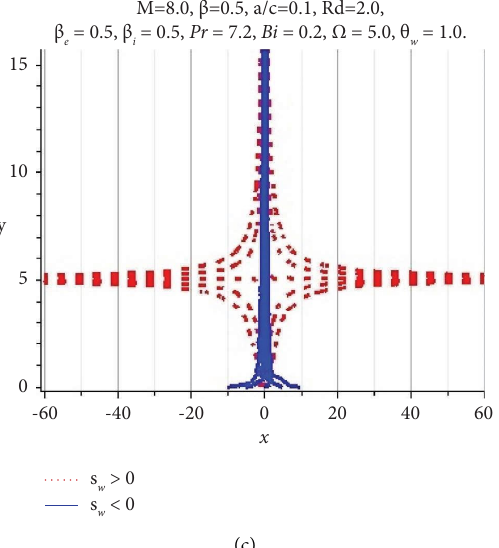
Figure 10: Stream lines (a) for permeability parameter with injection, (b) for permeability parameter with suction, and (c) for suction and injection. Table 1: Consequences of local heat fux − θ ′ ( 0 ) for restrictive case when Bi ⟶ ∞ . Pr Existing